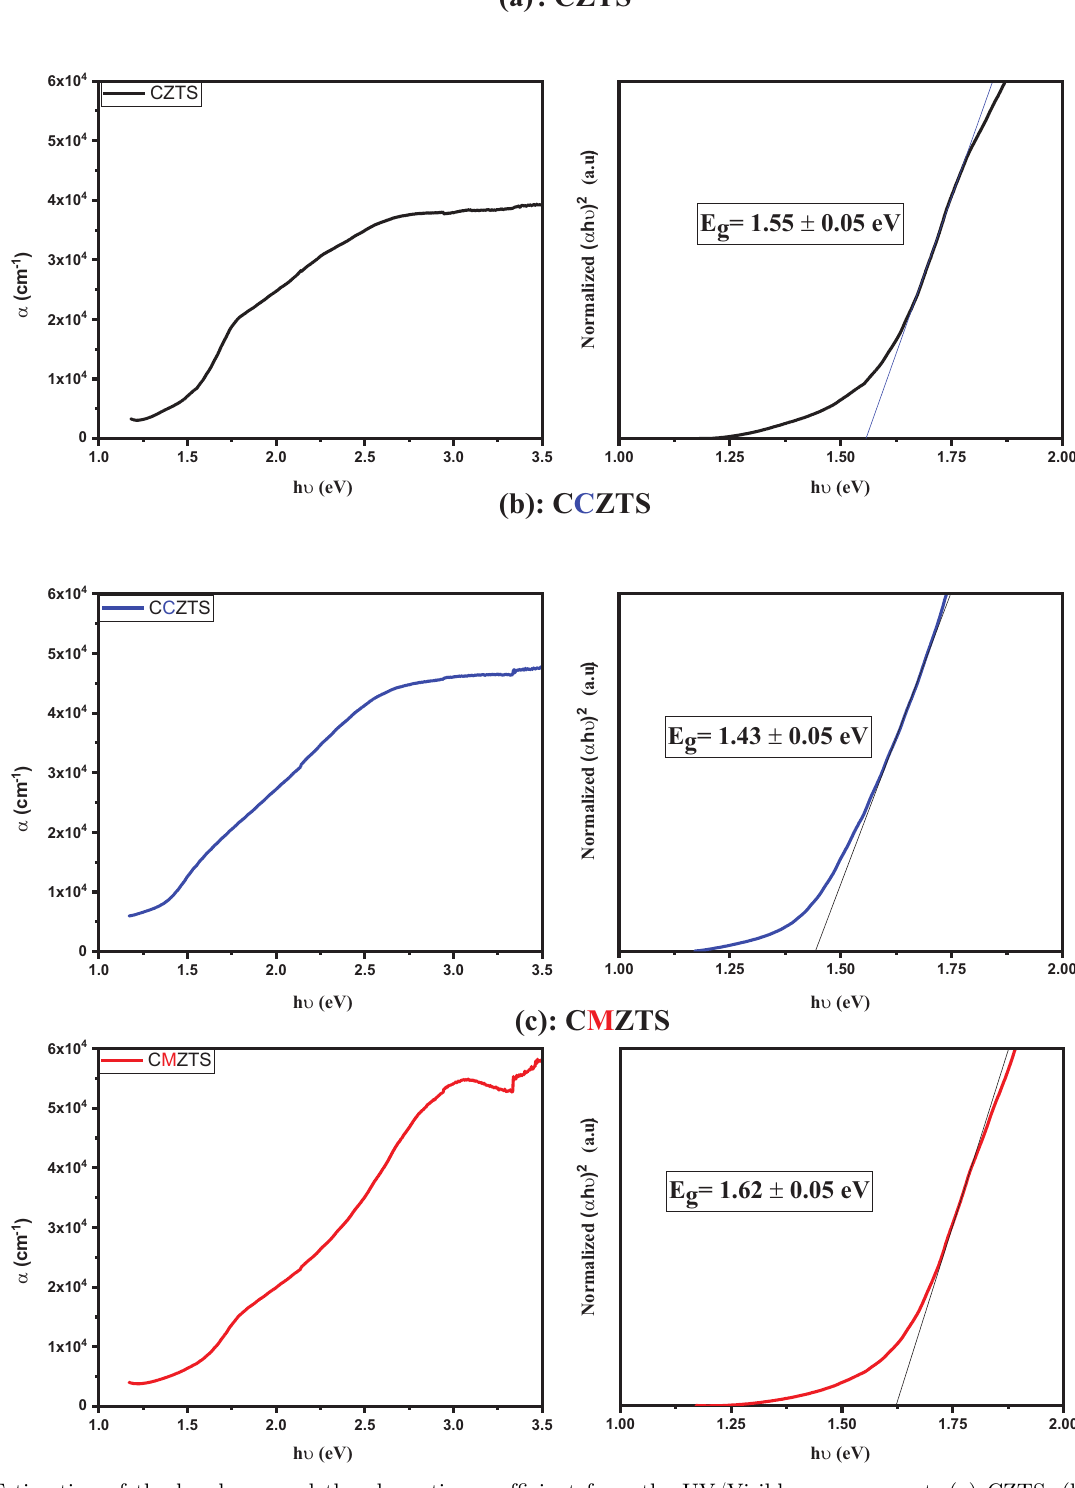
Fig. 4. Estimation of the band gap and the absorption coef fi cient from the UV/Visible measurement. (a) CZTS, (b) CCZTS, (c)